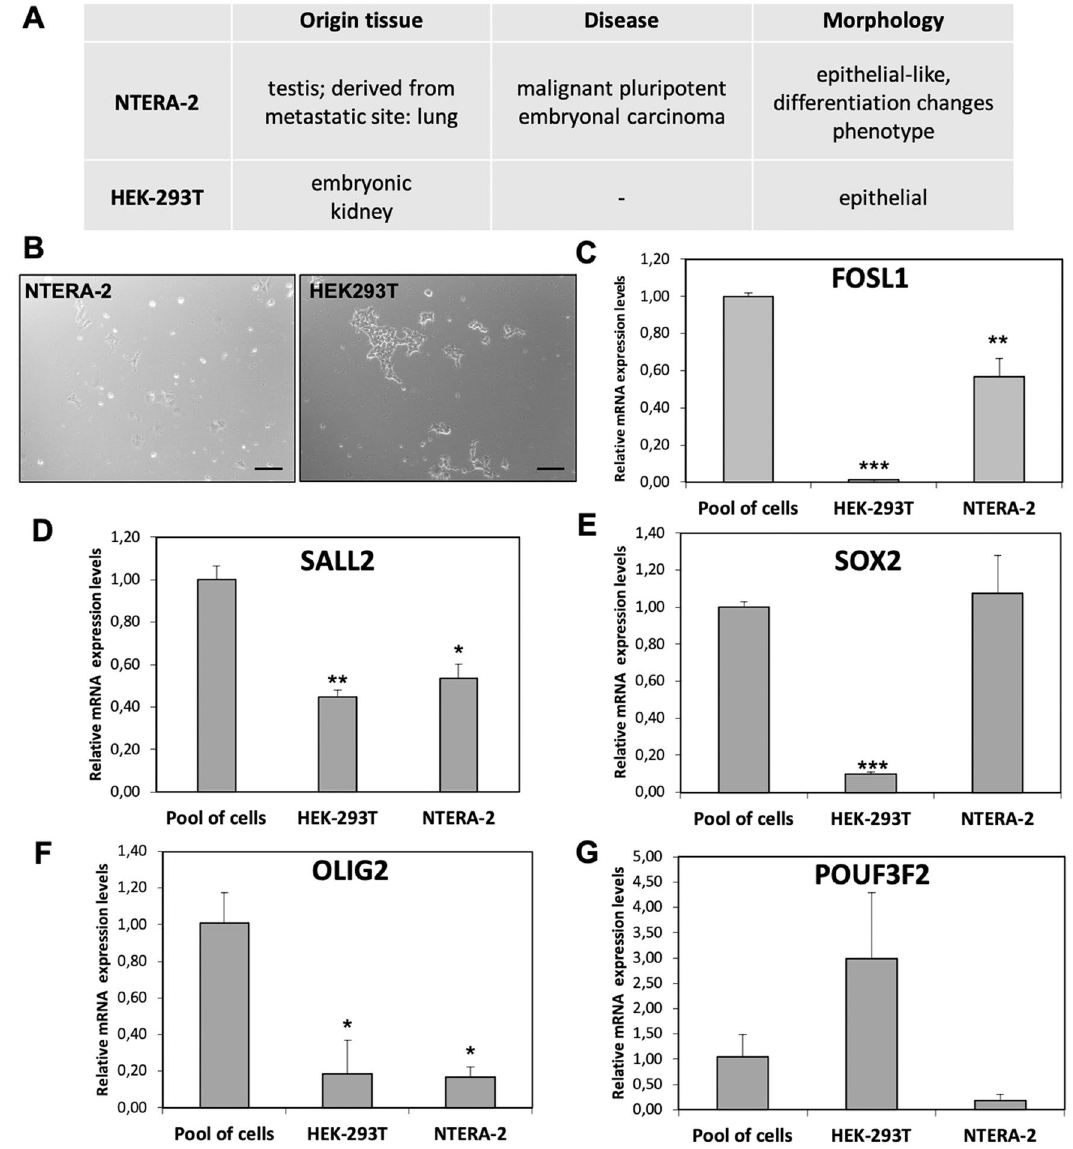
Figure 1. Cell lines characteristics and TFs expression levels. ( A ) Summary of cell lines characteristics. ( B ) Morphology of the NTERA-2 and HEK293T, 10X magnification, bar length 200 µm. ( C – G ) Relative expression levels of FOSL1, SALL2, SOX2, OLIG2 and PUO3F2. The Pool of cells sample is a pool of equimolar cDNA of 8 commercial cell lines used as control sample (HEK293T, NTERA-2, HeLa, NthyORI, 8505c, SW1736, TT, MZ-CRC1). Data are presented as mean ± standard deviation of the relative expression of each target, corrected for the GAPDH expression (housekeeping gene), and compared with the expression level of the same target in the pool of cells (calibrator). p value < 0.05, *; 0.005 **; 0.0005 *** (t-test FOSL1 reduces the cells’ ability to generate aggregates increasing the extracellular matrix component FN1. According to results obtained by Fiscon et al. 21 , FOSL1 seems to directly correlate with higher levels of extracellular matrix and focal adhesion components. In order to investigate the relationship between FOSL1 and extracellular components, we analyzed the ability of cells to generate aggregates in the extracellular matrix mix from Engelbreth-Holm-Swarm cells, the Matrigel. HEK293T cell lines transfected with FOSL1 (pCMW-FOSL1) or the empty vector were photographed every two days. After one week, the cells formed aggregates. As shown in Fig. 5A, cells that overexpressed FOSL1 seemed to generate less aggregates than cells transfected with the empty vector. This suggests a lower motility of cells transfected with FOSL1 , which may be due to the greater quantity of extracellular matrix components expressed in these cells when FOSL1 was overexpressed. The number of aggregates formed by each cell lines in the different conditions analyzed are reported in Fig. 5B.